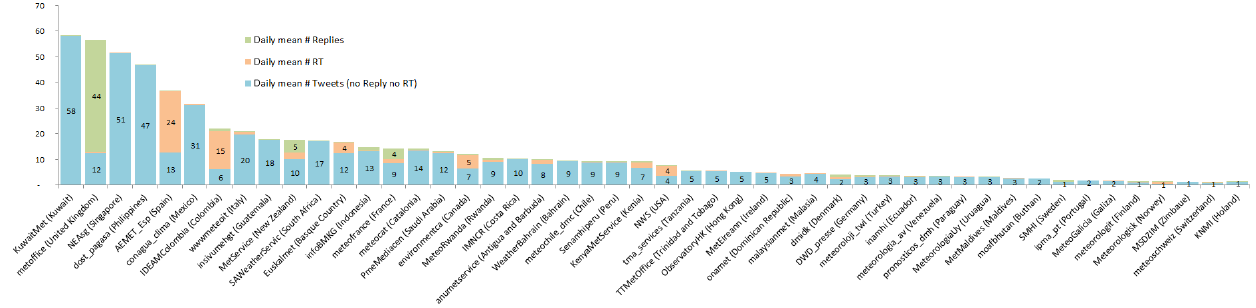
Figure 2. Average daily number (#) of tweets posted by different WS including the proportion of Retweets (RT) and